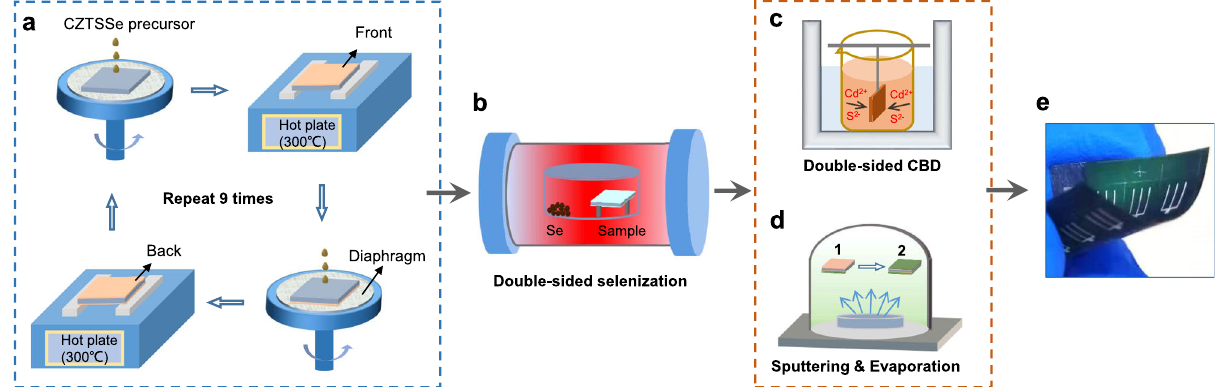
Fig. 2 Schematic illustration of the double-sided deposition techniques. a Circularly spin-coating precursor solution and annealing for deposition of double-sided CZTSSe prefabricated fi lm. b Selenization treatment for double-sided crystalline CZTSSe fi lm. c The CBD process for deposition of double- sided CdS fi lm. d Vacuum methods including sputtering and evaporation for fabrication of double-sided ZnO/ITO/Ag layers. e The photograph of bifacial fl exible CZTSSe